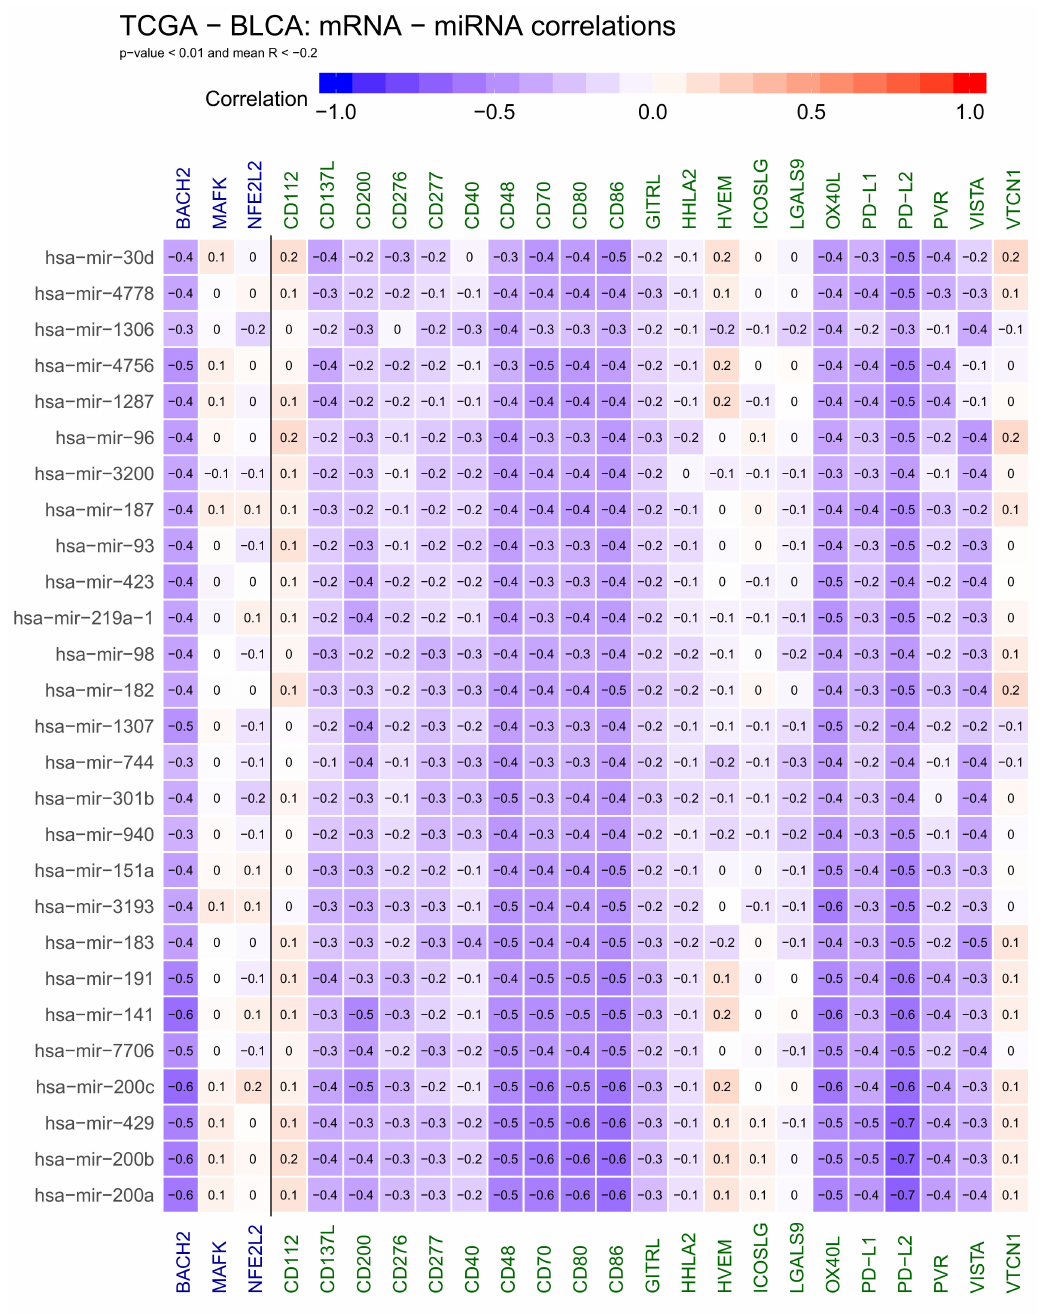
Figure 1. Heatmap showing negative correlations between selected genes active at cancer side of the immunological synapse: CD112, CD137L, CD200, CD276, CD277, CD40, CD48, CD70, CD80, CD86, GITRL, HHLA2, HVEM, ICOSLG, LGALS9, OX40L, PD − L1, PD − L2, PVR, VISTA and VTCN1, transcription factors: BACH2, MAFK and NFE2L2 and miRNA. Negative correlations are shown in blue. The numbers in heatmap tiles represent the correlation coefficients. The following statistical criteria were used to filter miRNA: correlation coefficient <= − 0.2 for anticorrelated microRNAs and statistical significance of correlation ( p -value from cor.test function in R) <